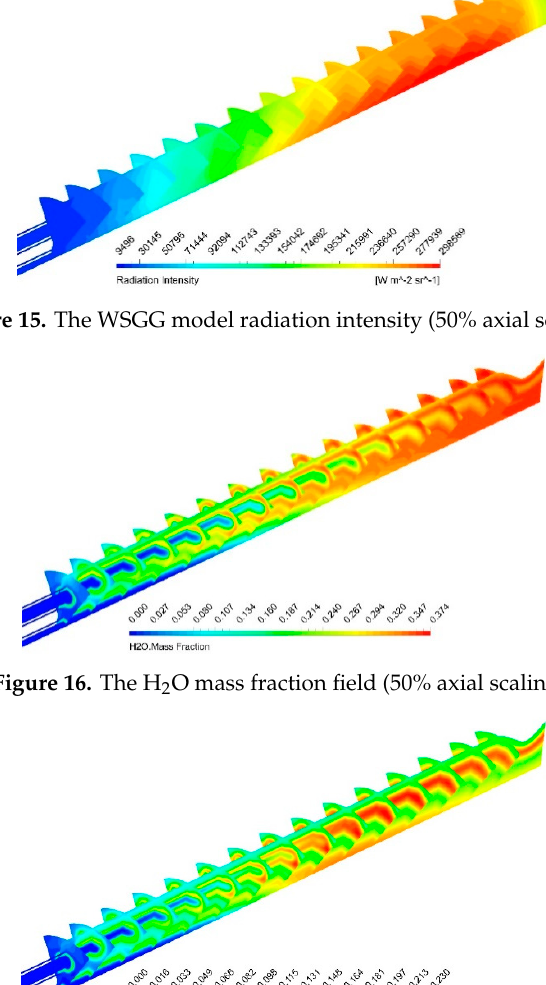
Figure 14. The Gray model radiation intensity (50% axial scaling).